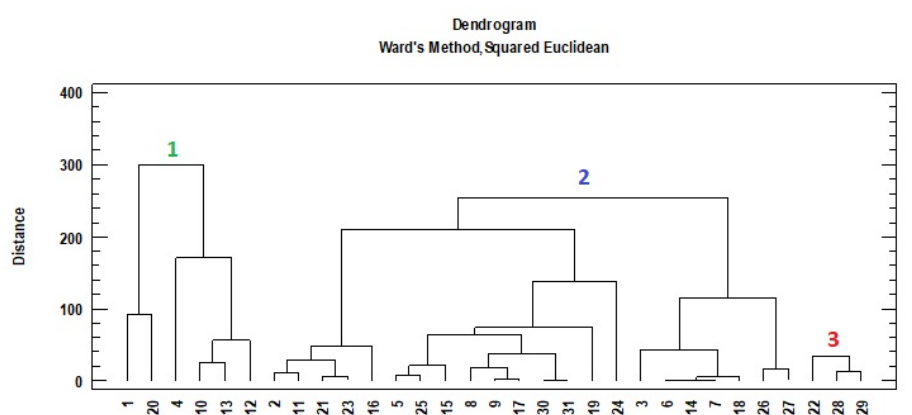
Figure 4. Dendrogram of cluster analysis with the distribution of bee pollen samples (1: group 1; 2: group 2; 3: group 3).